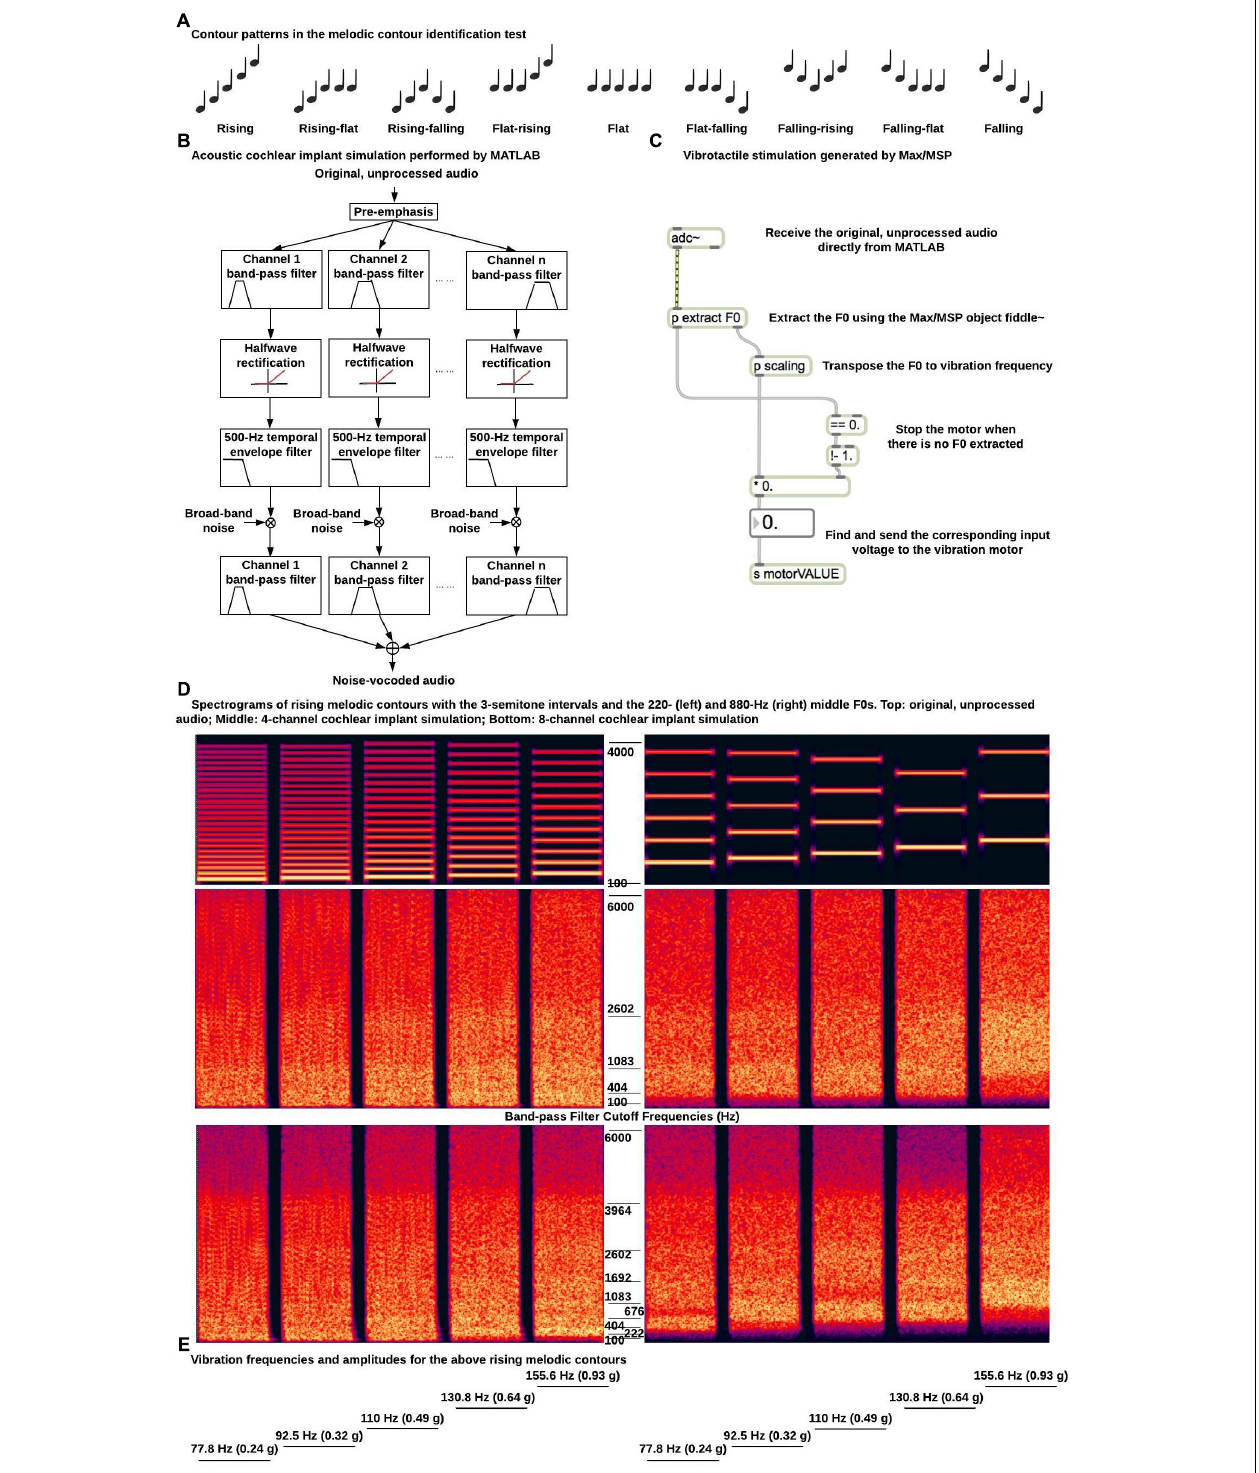
FIGURE 2 | Example stimuli and signal processing for the melodic contour identification test. (A) Nine contour patterns used in the melodic contour identification test; (B) Diagram of acoustic simulation of CI processing; (C) Diagram of signal processing for vibrotactile stimulation; (D) Spectrograms of rising melodic contours with the 3-semitone intervals and the 220 (left) and 880 Hz (right) middle F0s (top, original, unprocessed audio; middle, 4-channel CI simulation; bottom, 8-channel CI simulation). The band-pass filter cutoff frequencies for the CI simulations are listed next to the spectrograms. (E) Vibration frequencies and amplitudes for the rising melodic contours in (D)